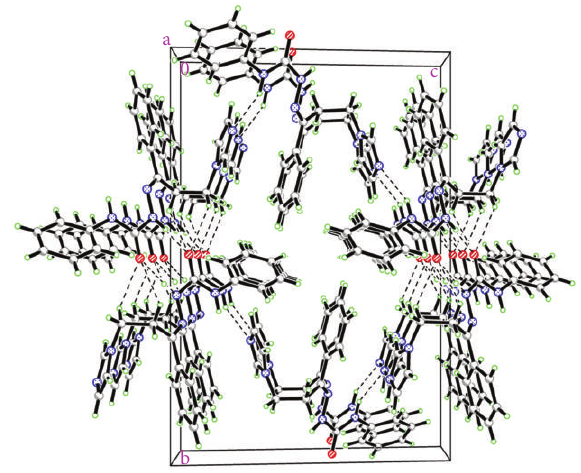
Figure 3: Crystal packing showing intermolecular N–H ⋅⋅⋅ O and C–H ⋅⋅⋅ O hydrogen bonds as dashed